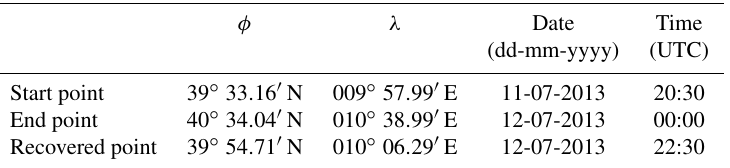
Figure 5. Downwind (up) and crosswind (down) components of leeway vs. 10m wind velocity. Each line’s beam, distinguishable by color, is generated by perturbing the error standard from a normal distribution N (0,sigma) and arbitrarily changing the corresponding correction coefficient. The black lines are generated by means of random perturbation of the originary sigma value shown in the Allen and Plourde (1999) table. The green lines are obtained by means of the coefficients of the standard errors proposed in Breivik and Allen (2008) (hereafter called reference coefficients). The red lines are generated by multiplying the reference coefficients by 4; therefore here the regression line coefficients are a n = a + (cid:15) n / 5 (slope) and b n = b + 2 · (cid:15) n (offset). The blue lines are obtained by selectively increasing the reference coeffi- cients (according to wind velocity) 4 times. Finally the yellow lines are calculated by only multiplying the slope reference coefficient by 4; therefore now the regression coefficients are a n = a + (cid:15) n / 5 (slope) and b n = b +− 0 . 5 · (cid:15) n (offset). Table 1. Data describing the